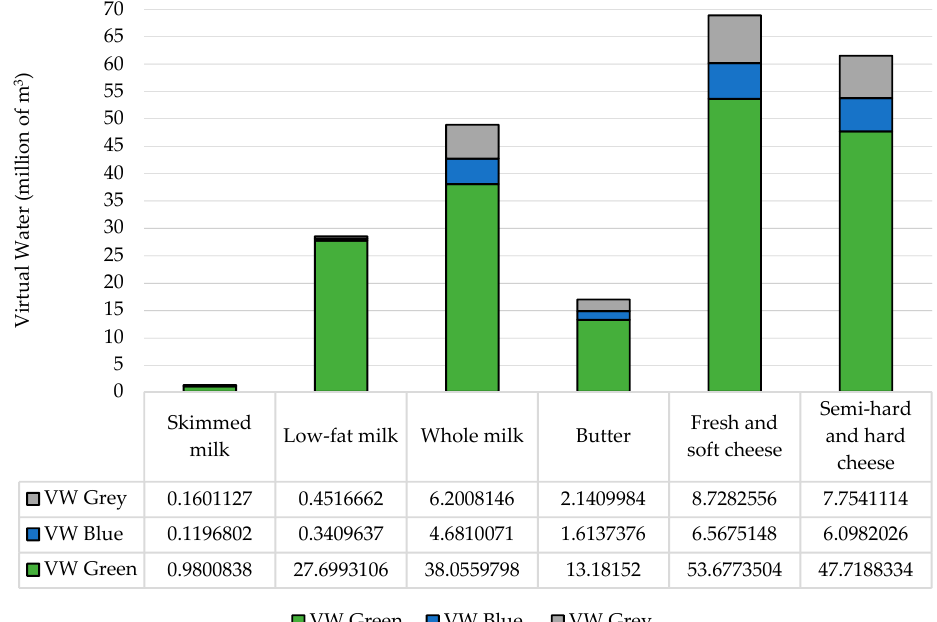
Figure 3. The blue, green, and grey virtual water of dairy products in Trentino Alto Adige in 2018. For all product categories, the green VW had the largest contribution to the total VW, while blue VW was extremely low in the production of skimmed milk, 1% of the total water, and for all the other categories did not exceed 10%. The grey VW was higher than the blue VW for all the analyzed products with greater values for butter, fresh and soft cheese, and semi-hard and hard cheese. This finding was similar to the results of Palhares and Pezzopane [27], Roibás et al. [65] and Owusu-Sekyere et al. [53], which also indicated green VW as the major component of the total VW for dairy products. The results revealed that the highest total VWs were associated with cheese. In fact, looking at the sum of the two types of cheese considered (fresh cheese and hard and semi- hard cheese), cheese was responsible for about 60% of the virtual water consumption of the entire sector, while representing less than 30% of total production. On the other hand, although about 68% of dairy production was represented by milk (whole, partially skimmed and skimmed), its incidence in terms of virtual water consumption was extremely lower than that of cheese (Figure 4). This result was in line with previous studies that evaluated the environmental impact of cheese production compared to other dairy products, finding that the cheese supply chain had the highest demands for raw materials, energy, and water [66,67]. Cheese production processing involves numerous steps that are both time-consuming and environmentally expensive [68], which make it the main product in the dairy industry due to its greater economic value. On the contrary, drinking milk, requiring fewer steps along the supply chain, necessitates a lower virtual water consumption (3–4% for each component) than all other dairy products.